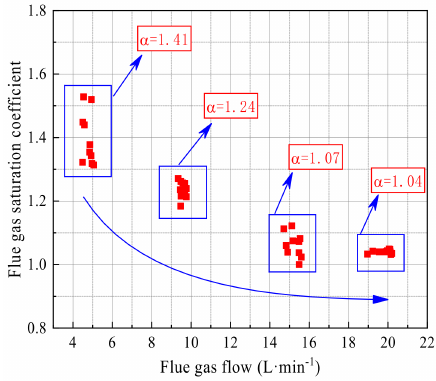
Figure 10. Supersaturation coefficient of flue